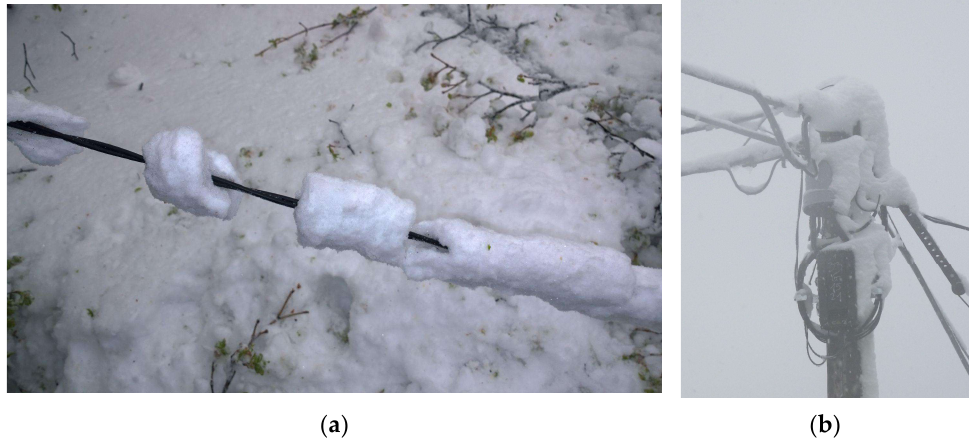
Figure 1. Photographs of wet snow accreted on power lines and poles ( a ) at Bükkszentkereszt on 20 April 2017 (courtesy of István Erdődi), the diameter of accreted snow sleeve was estimated between 7 and 8 cm, ( b ) near Budapest János-hegy on 19 April 2017 (photo by André Simon).